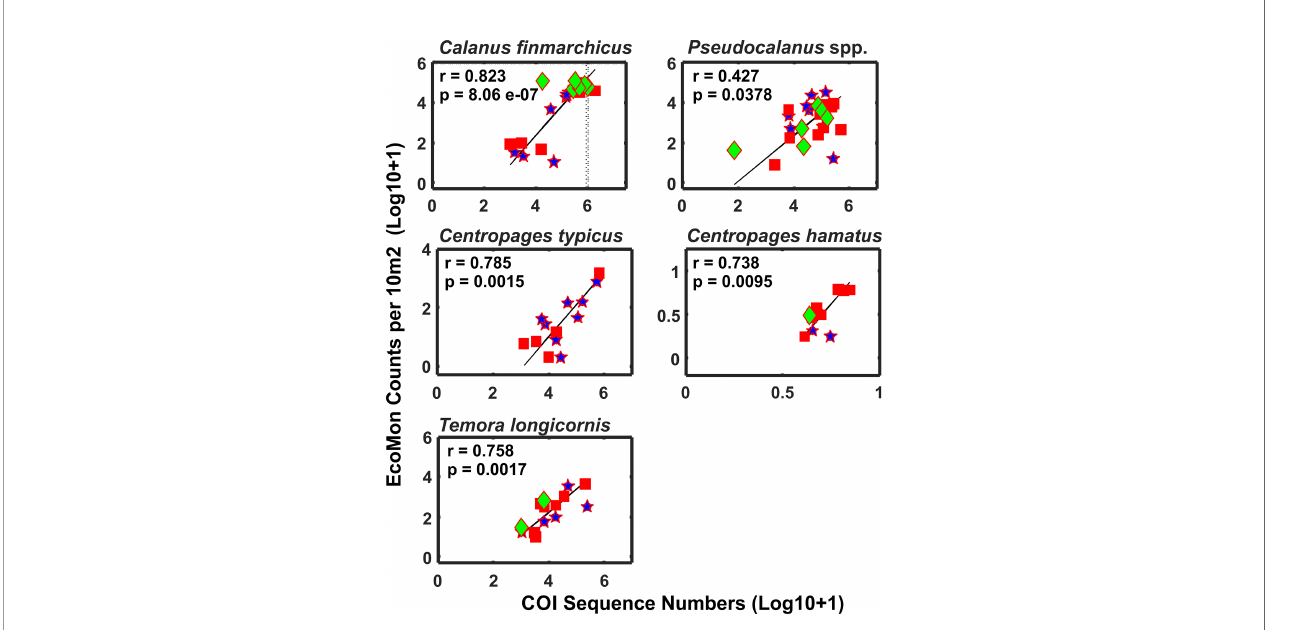
FIGURE 10 | Functional regression analysis of COI sequence numbers and EcoMon microscopic counts per 10 m 2 for abundant copepods that were detected by COI metabarcoding and also counted by EcoMon microscopic analysis ( Supplementary Tables S1 , S2 ). COI sequences for all Pseudocalanus species detected were added for comparison with Pseudocalanus spp. counts from the EcoMon database. Species were selected based on availability of molecular and morphological data for suf fi cient numbers of samples to allow regression analysis. Numbers are Log 10 + 1